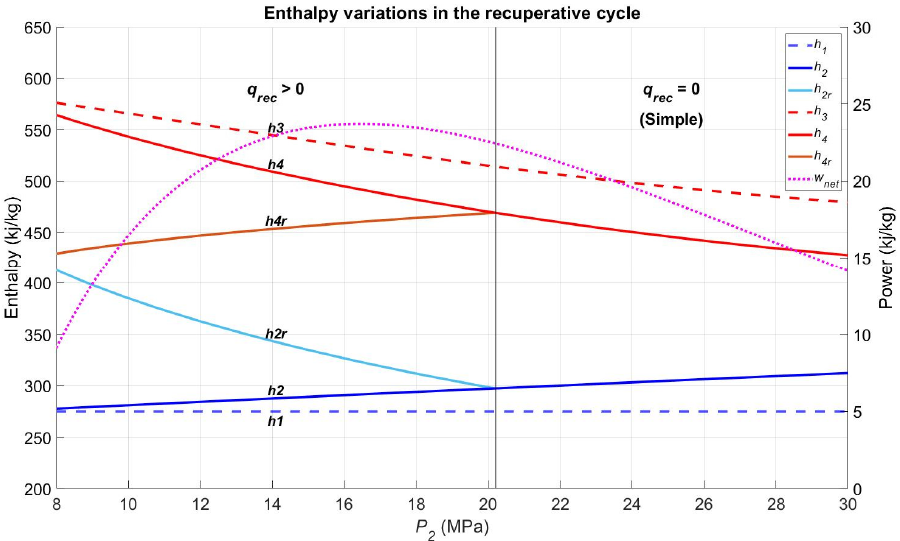
Figure 10. Enthalpy variations at each state point in the recuperative cycle regarding P 2 ( T h , in = 150 ◦ C; η p = η e =